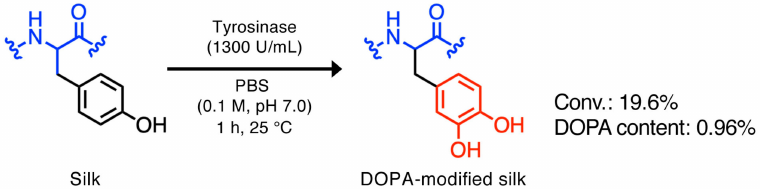
Scheme 1. Tyrosinase-catalyzed DOPA modification of silk. Silk solution was mixed with tyrosinase